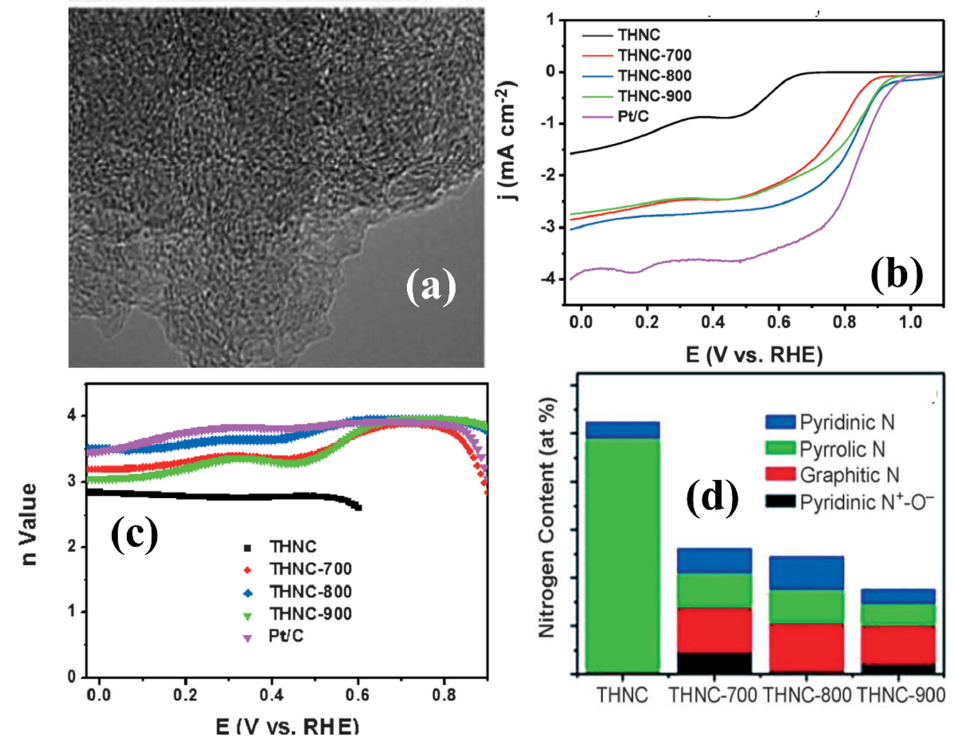
Figure 4. ( a ) TEM image of THNC-800, ( b ) RRDE voltammograms of the same electrodes at the rotation rate of 1600 rpm. Scan rate: 10 mVs − 1, ( c ) variation of n values of THNC, THNC-700, THNC-800, THNC-900, and Pt/C at different potentials, ( d ) graphical representation of the nitrogen content in the carbon samples, adapted from [51].